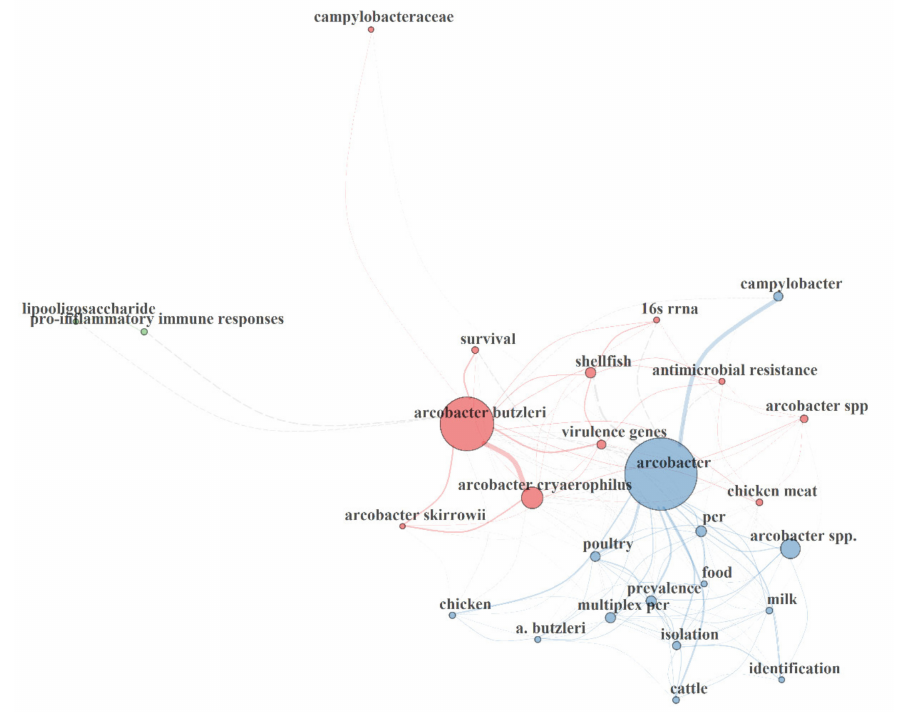
Figure 6. Keywords co-occurrence collaboration map.